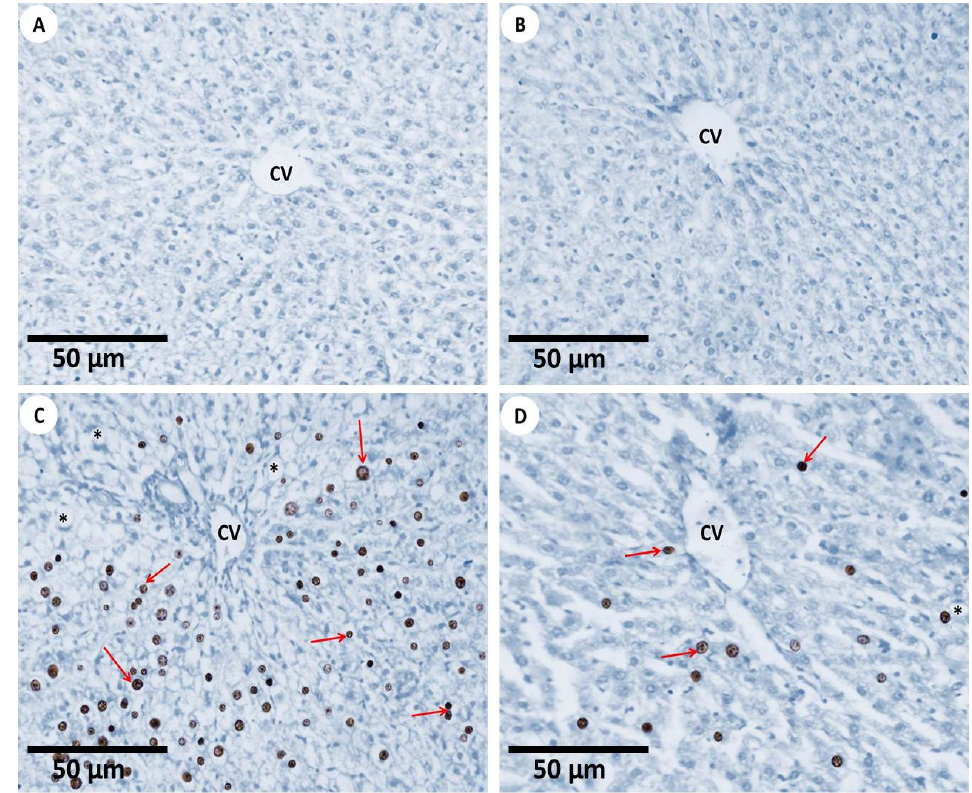
Figure 7. Light explanation microscopy for histochemistry apoptotic cells ( A ) Mouse liver section from the first group displaying no TUNEL-positive apoptotic cells in the healthy tissues of hepatocytes around the central hepatic vein (CV) (TUNEL, 400 × ). ( B ) Mouse liver section from the second group showing the normal distribution of normal hepatocytes in the hepatic cord found around the central vein (CV) (TUNEL, 400 × ). ( C ) The mouse liver section from the third group that detected the